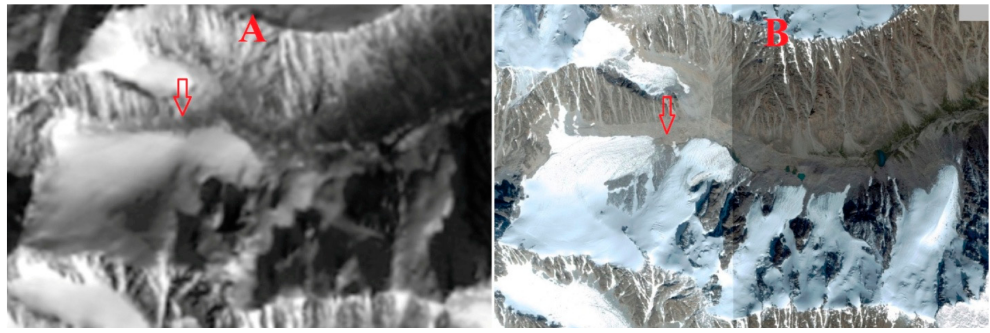
Figure 8. Degradation of a glacier in Burgastyn-Gol valley, Chihacheva ridge (Ikh Turgen). ( A ): Landsat-4 image, 1989; ( B ): Geoeye-1 satellite image, 24 July